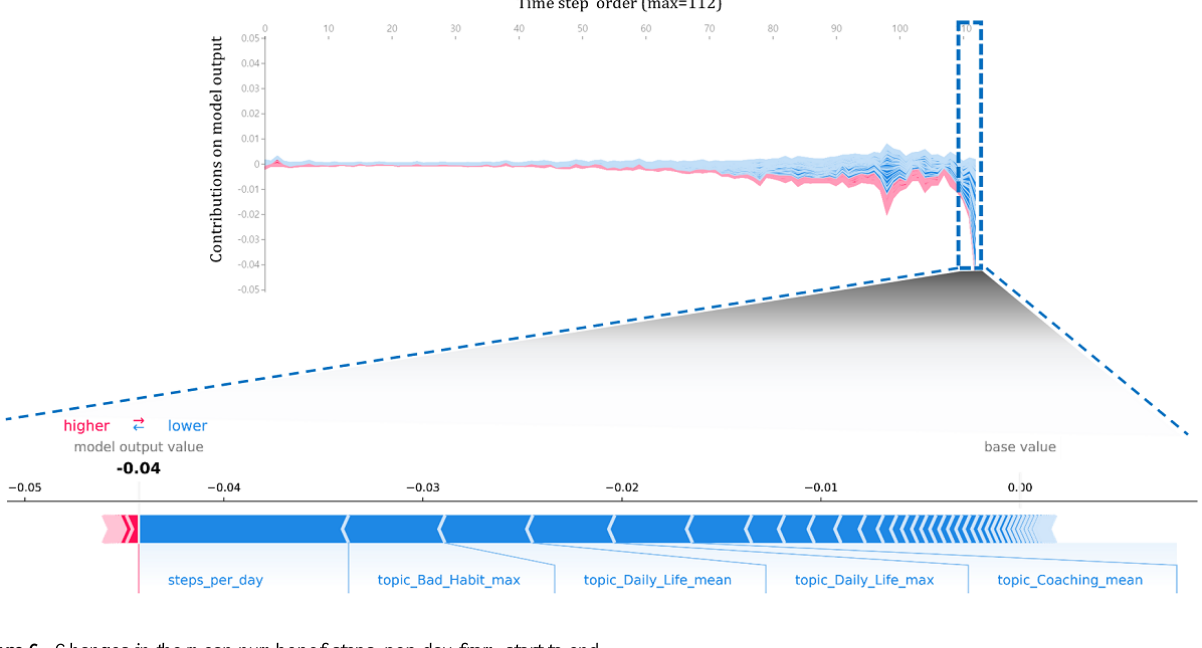
Figure 5. Retained users’daily average contribution of variables over time (above, line plot) and contributions of each variable on the last day (below, bar plot).